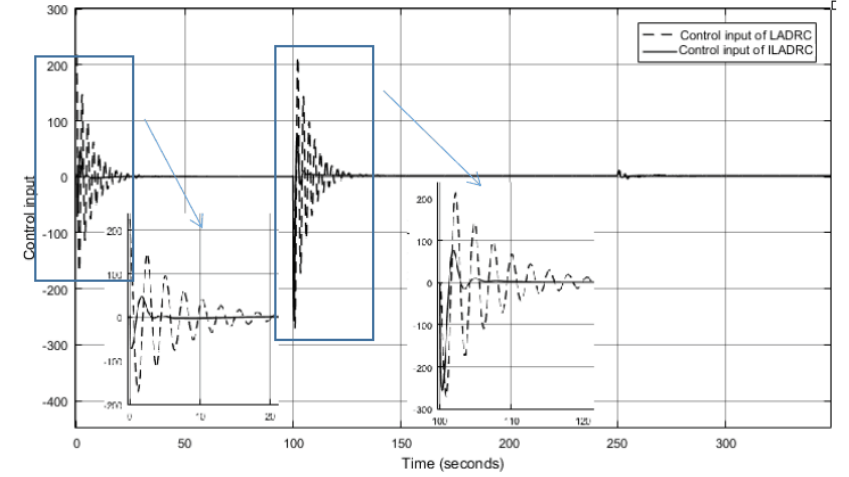
Figure 7. Comparison of control input with the model parameter G W increasing between LADRC and